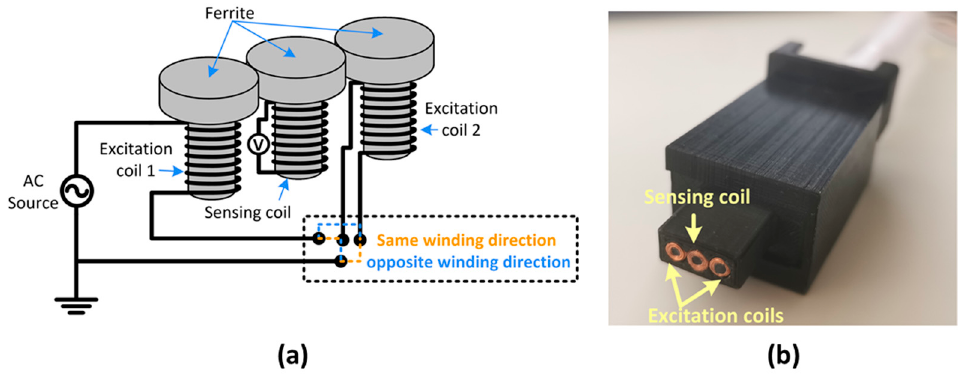
Figure 11. ECT probe used to evaluate the condition of the CFRP specimen: ( a ) schematic and ( b ) photograph.